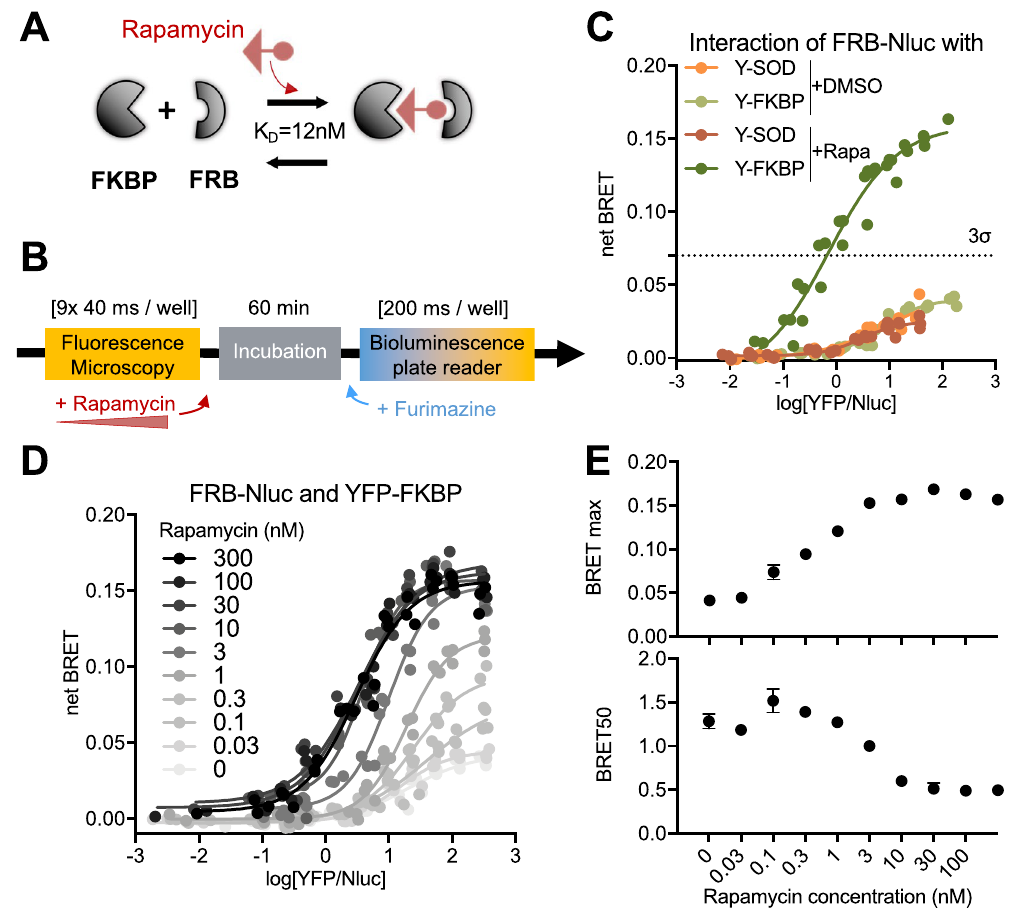
Figure 3. Monitoring the drug-dependent FRB-FKBP interaction with variable donor BRET saturation assays. ( A ) Simplified dynamics of the interaction of FKBP with the FRB domain of mTOR mediated by the rapamycin. ( B ) HEK-293T cells were incubated in presence of rapamycin for 1 h between fluorescence and bioluminescence acquisition. ( C ) Variable donor BRET saturation assay of FRB-Nluc/YFP-FKBP in the presence or absence of rapamycin. A 3 σ-threshold (0.07) was defined based on SOD-FRB interactions considered a negative control. ( D ) Variable donor BRET saturation assay of FRB-Nluc/YFP-FKBP in cells treated with various concentrations of rapamycin for 1 h. ( E ) BRETmax and BRET50 values were plotted according to the different concentrations of